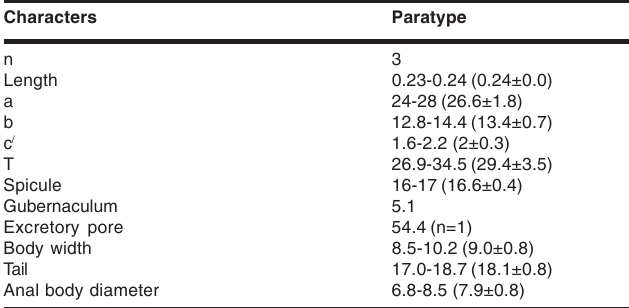
Table 3. Measurements of the male of Paratylenchus thysanolus sp. nov. All measurements in μ m, except L in